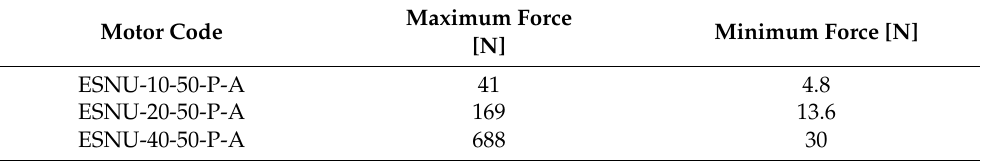
Table 4. Forces developed by the ESNU pneumatic cylinders.